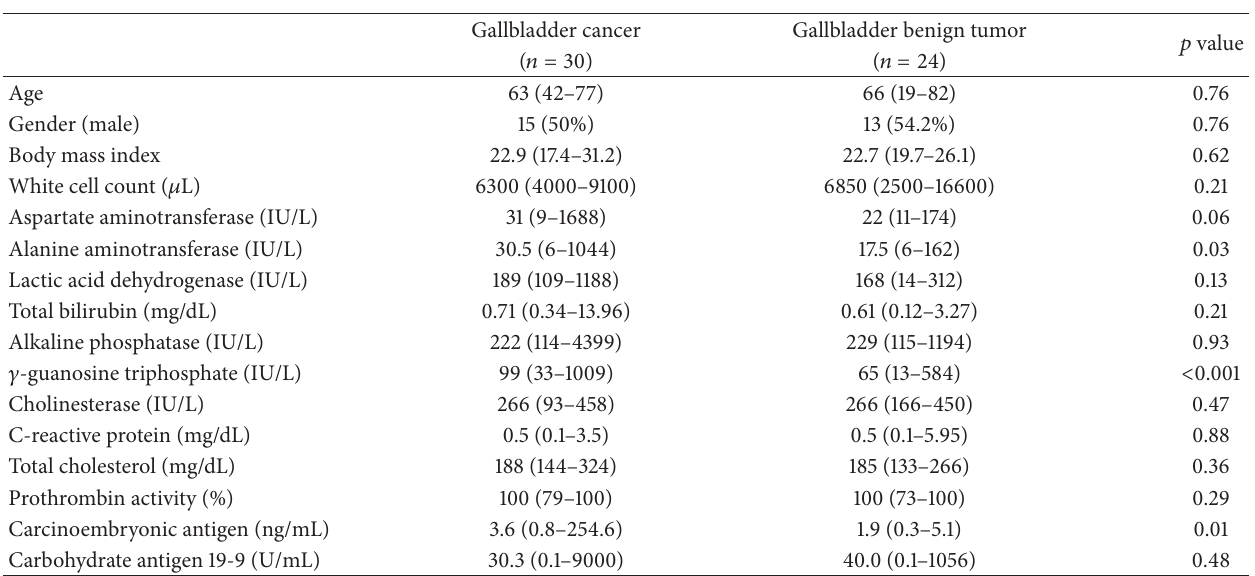
Table 1: Patient